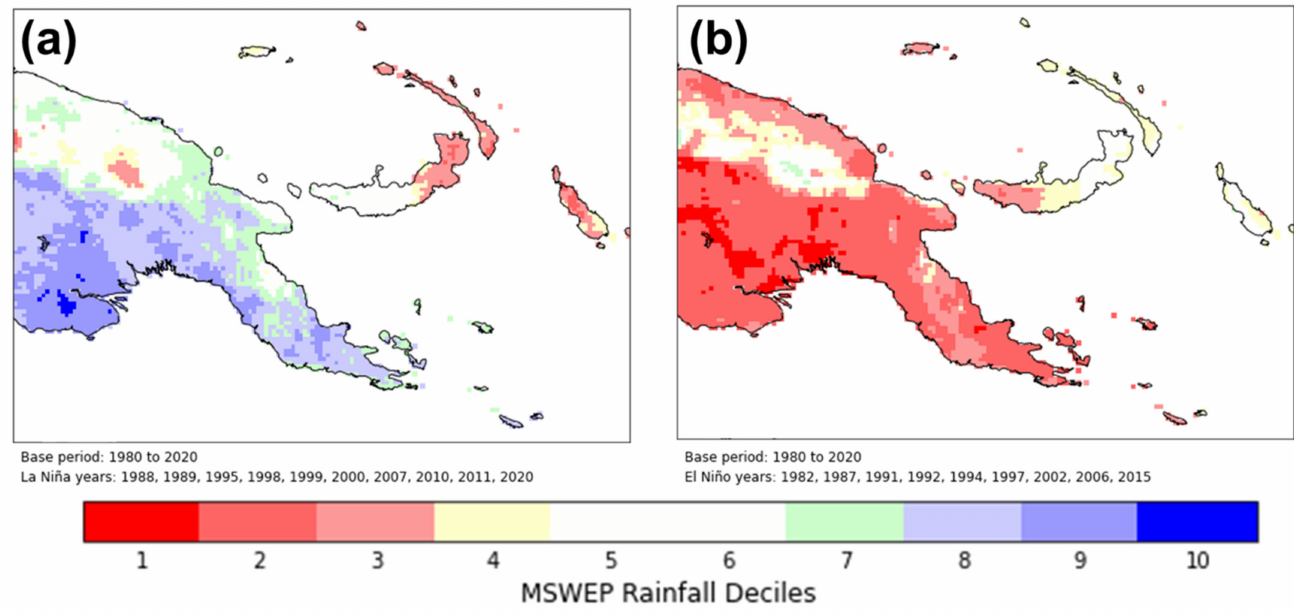
Figure 14. MSWEP rainfall deciles in ( a ) La Niña and ( b ) El Niño events compared to a base period of